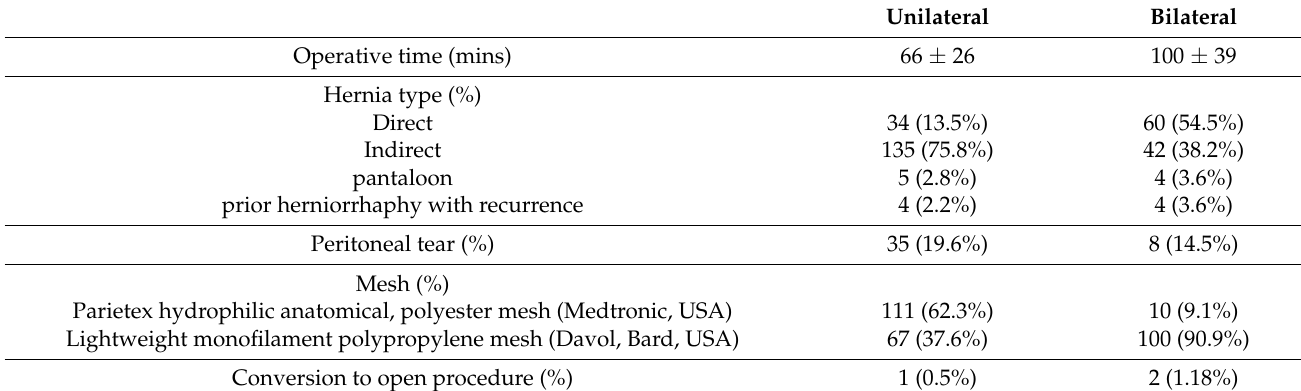
Table 2. Perioperative